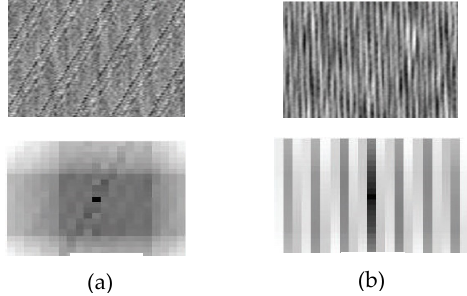
Figure 13. Examples of the generated 2D gray-level images and their corresponding 2D DNS map for ( a ) bearing fault, and ( b ) rotor imbalance fault [49].